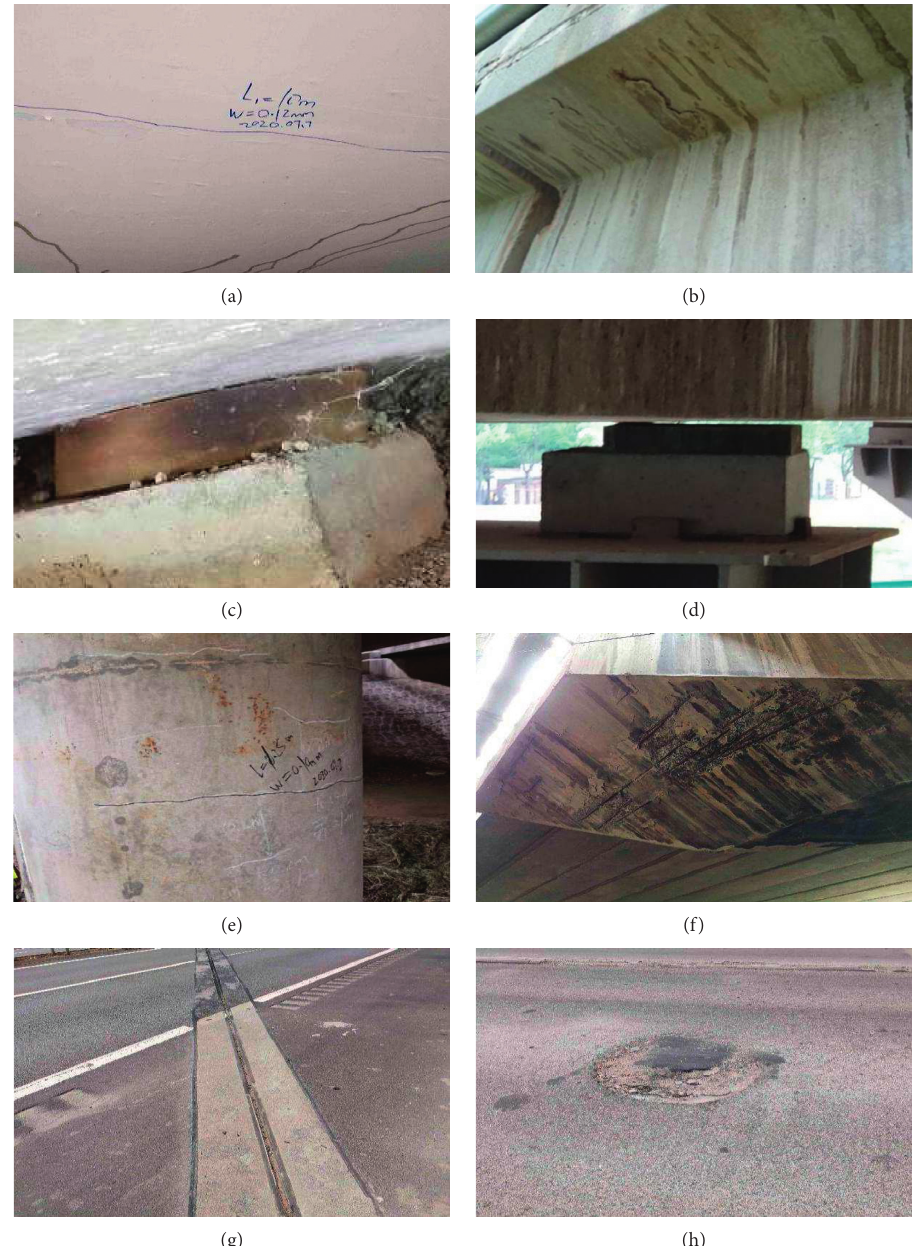
Figure 1: Common bridge diseases; (a) longitudinal cracks at the bottom of the beam, (b) corrosion of hollow-core slab reinforcement, (c) bearing shear deformation; (d) bearing separation; (e) circumferential cracks in bridge piers; (f) corrosion of cover beam reinforcement; (g) cracking and blocking of the anchorage area of the expansion joint; (h) bridge deck